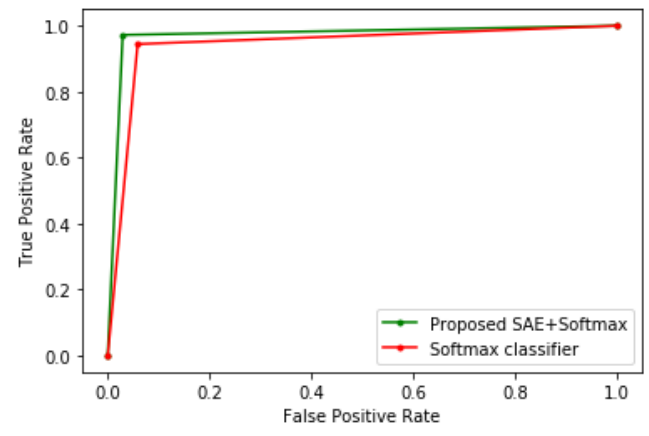
Figure 4. ROC curve of the cervical cancer model.